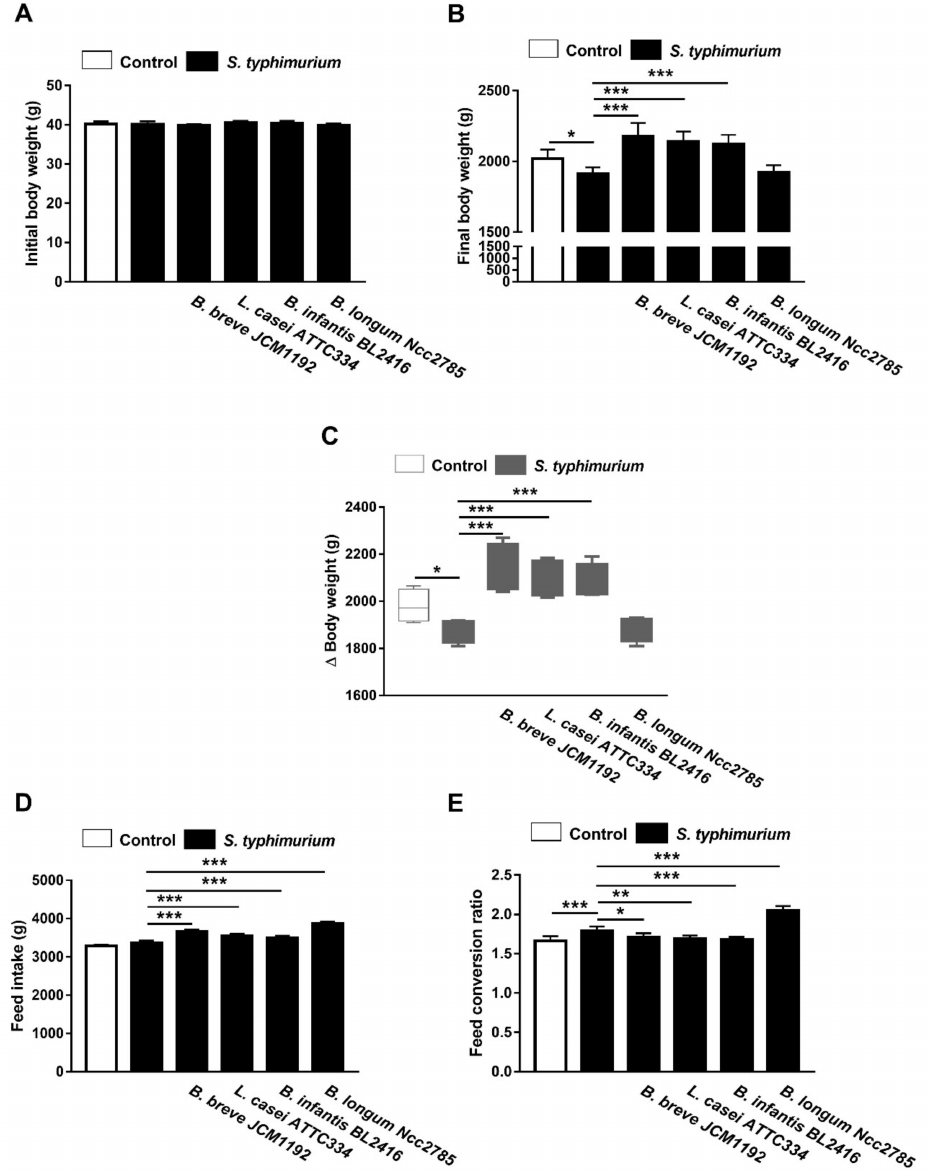
Figure 2. E ff ect of Bifidobacteria and Lacticaseibacillus probiotics on growth performance of broiler chickens challenged with S. typhimurium. Probiotics improved body weight gain ( A – C ), feed intake ( D ) and feed conservation ratio ( E ). Data are mean ± SD, ( n = 10). * p < 0.05, ** p < 0.01 and *** p <